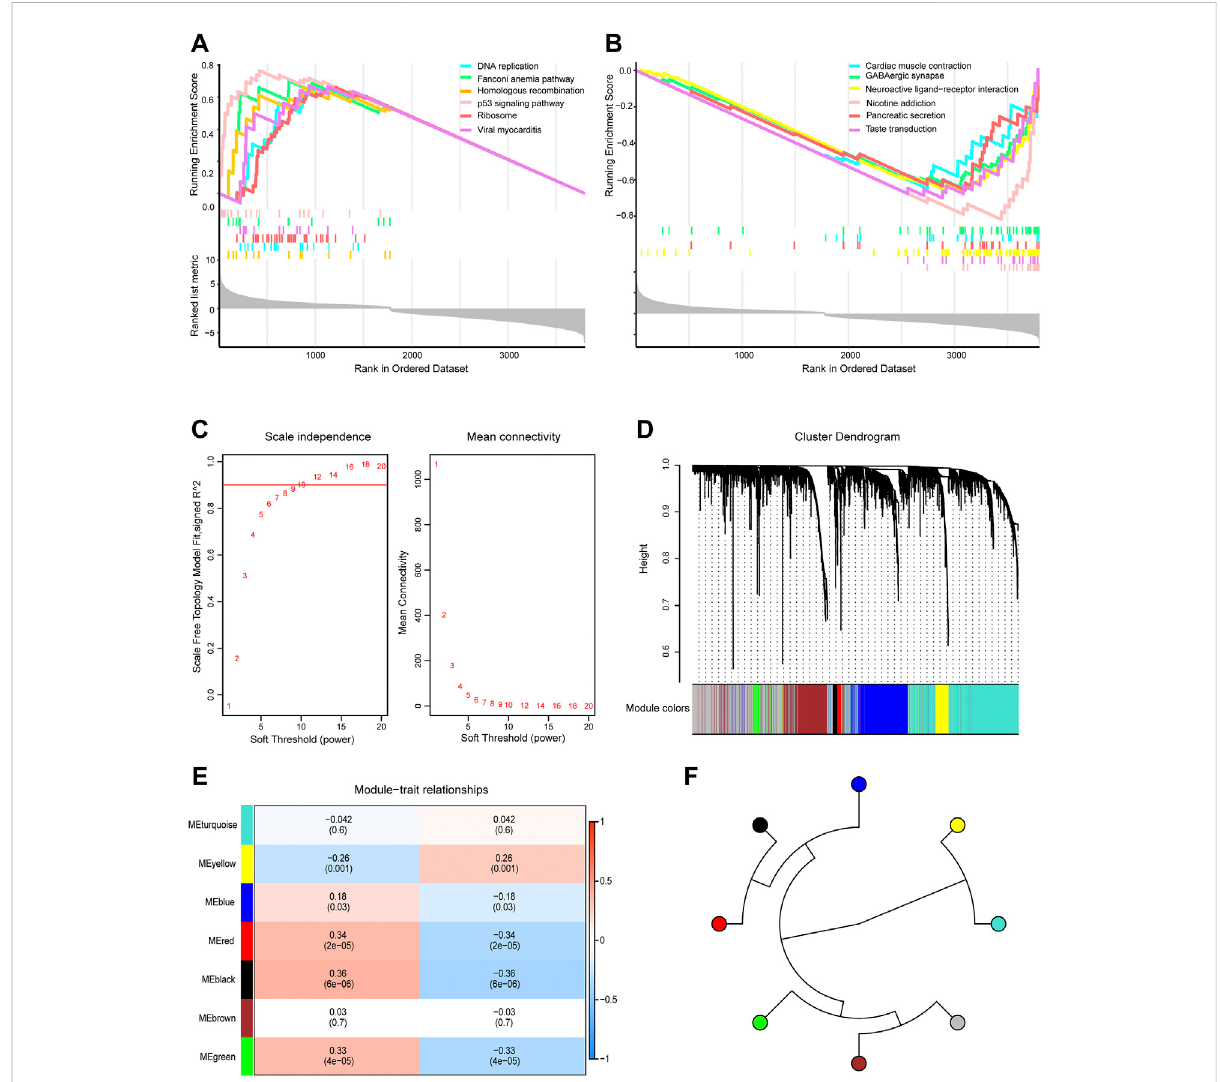
FIGURE 3 Gene Set Enrichment Analysis (GSEA) and Weighted Gene Co-expression Network Analysis. (A) GSEA showed head of six pathways enriched in glioblastoma (GBM) patients. (B) GSEA showed tail of six pathways enriched in GBM patients. (C) Network topology analysis under different soft threshold power. (D) Cluster tree showed co-expression modules based on WGCNA. (E) Correlation between seven key modules and clinical traits. (F) Correlation between the modules in